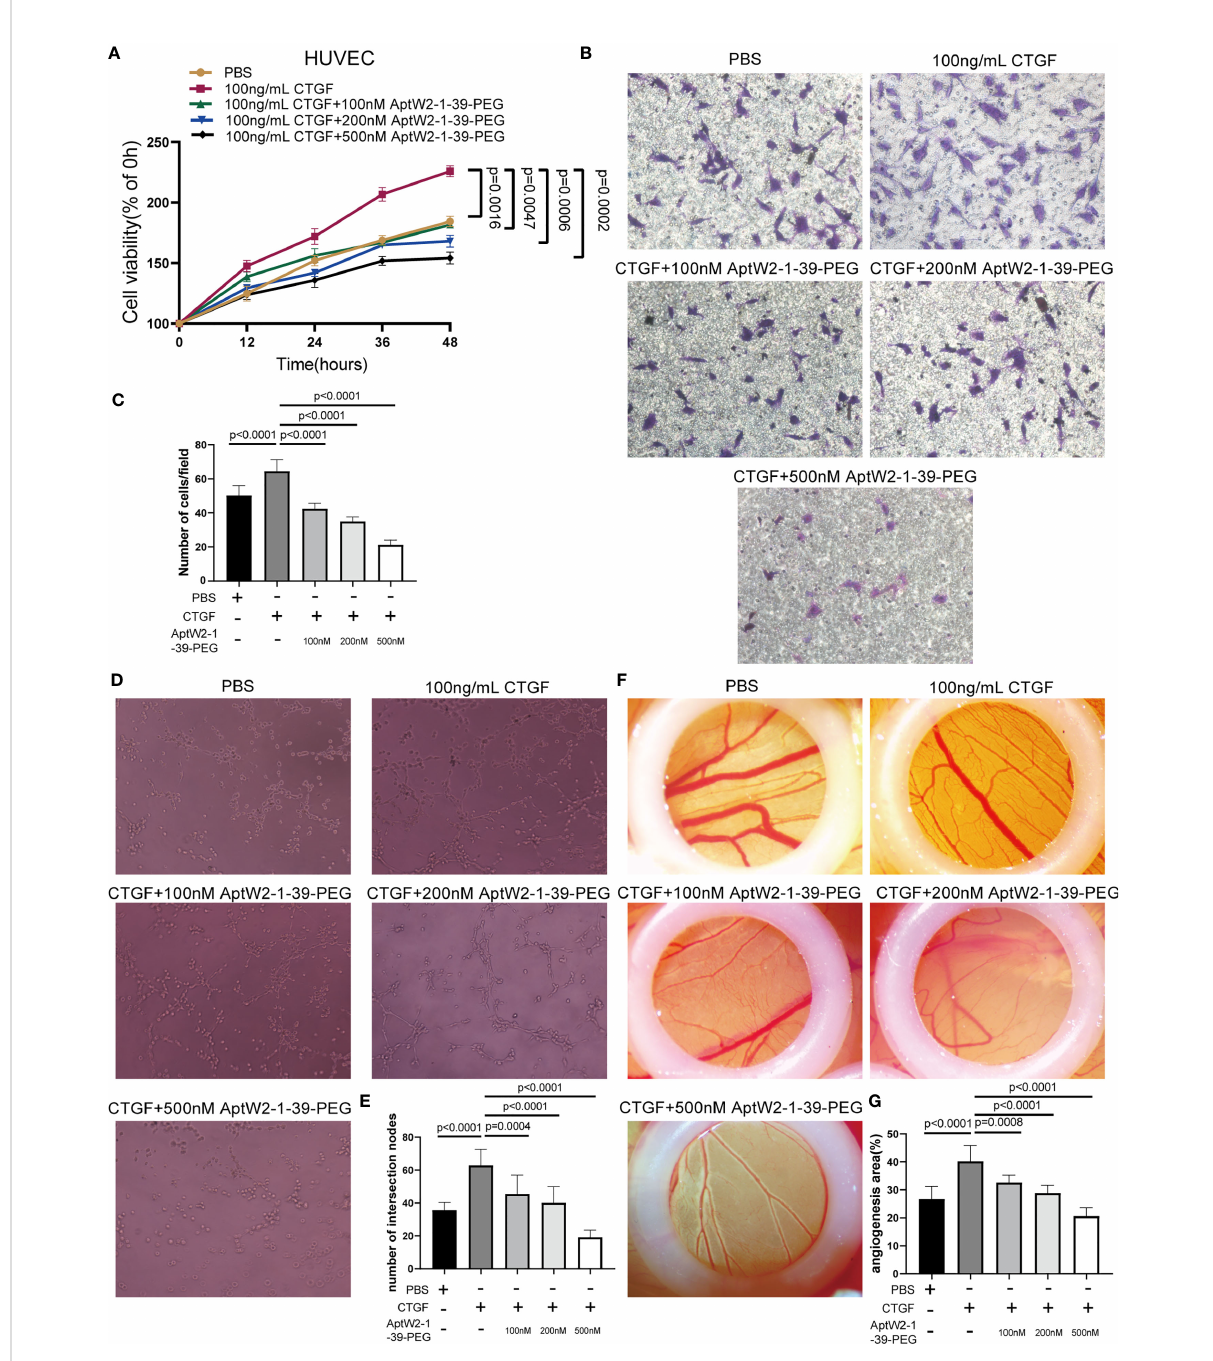
FIGURE 4 Restrained effect of AptW2-1-39-PEG on the proliferative and angiogenic activities induced by CTGF. (A) CCK8 assay. HUVECs were treated with CTGF (100 ng/ml) and AptW2-1-39-PEG (100 nM, 200 nM, and 500 nM) for 12 h, 24 h, 36 h, and 48 h, respectively. The absorbance value of each well at a wavelength of 450 nm was measured. (B, C) HUVECs were plated onto the top of the transwell microplates, allowed to migrate for 12 h, and then rinsed, fi xed, stained, and counted. (B) Images of cells on the undersurface of a fi lter are shown (original magni fi cation, 200×). (C) The number of cells per fi eld in the control and treated cells is shown. (D, E) Three-dimensional tube formation assay. HUVECs were treated with CTGF (100 ng/ml) and AptW2-1-39-PEG (100 nM, 200 nM, and 500 nM) for 6 h. (D) Tube formation was observed and photographed. (E) The number of intersection nodes was calculated in the whole fi eld. (F, G) CAM assay. CAM were treated with CTGF (100 ng/ml) and AptW2-1-39-PEG (100, 200, and 500 nM) on day 7. (F) Neonatal blood vessels were photographed 3 days later. (G) ImageJ was used to assess the vascular and CAM areas. The percentage of the angiogenic area = vascular area/CAM area × 100%. The data are presented as mean ±